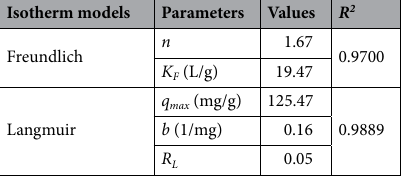
Isotherm models Parameters Values R